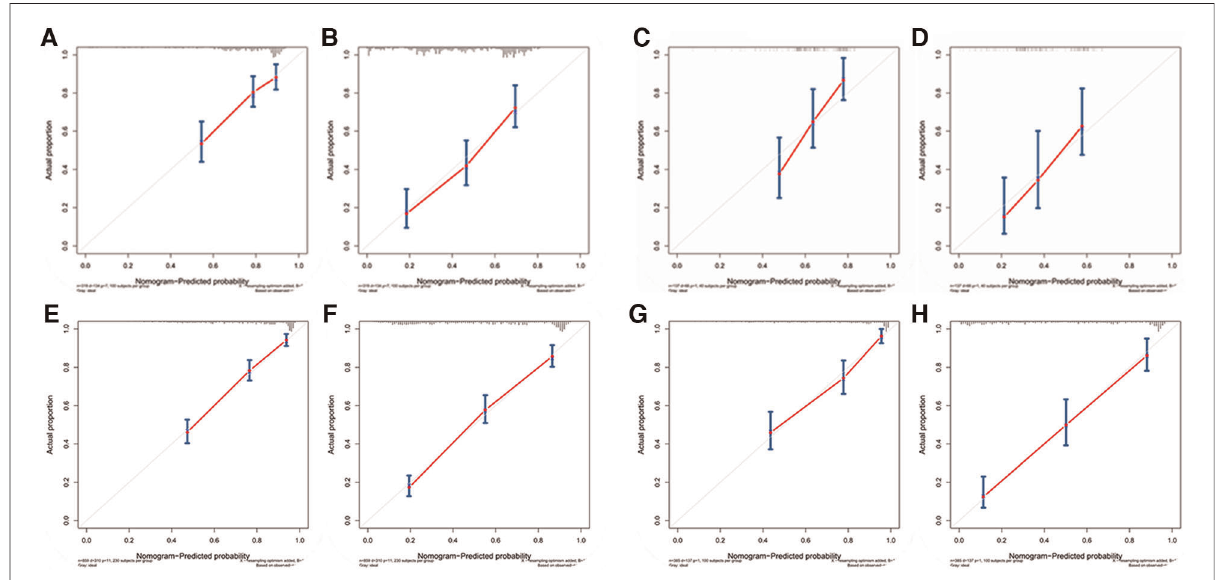
FIGURE 3 ( A ) Calibration curves of internal validation to predict 3- year OS of chemotherapy cycles <9, ( B ) Calibration curves of external validation to predict 3- year OS of chemotherapy cycles <9, ( C ) Calibration curves of internal validation to predict 5- year OS of chemotherapy cycles <9, ( D ) Calibration curves of external validation to predict 5- year OS of chemotherapy cycles <9, ( E ) Calibration curves of internal validation to predict 3- year OS of chemotherapy cycles ≥ 9, ( F ) Calibration curves of external validation to predict 3- year OS of chemotherapy cycles ≥ 9, ( G ) Calibration curves of internal validation to predict 5- year OS of chemotherapy cycles ≥ 9 and ( H ) Calibration curves of external validation to predict 5- year OS of chemotherapy cycles ≥